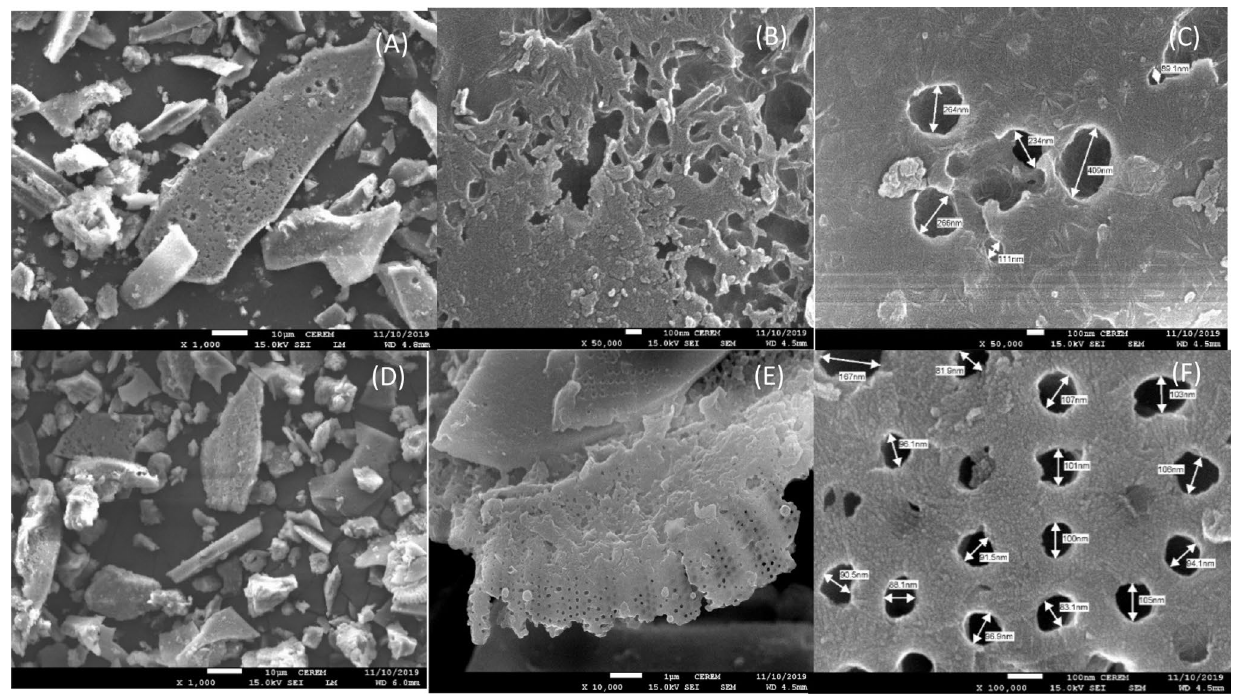
Figure 1. SEM images of the clay WTC ( a – c ), ATC ( d – f